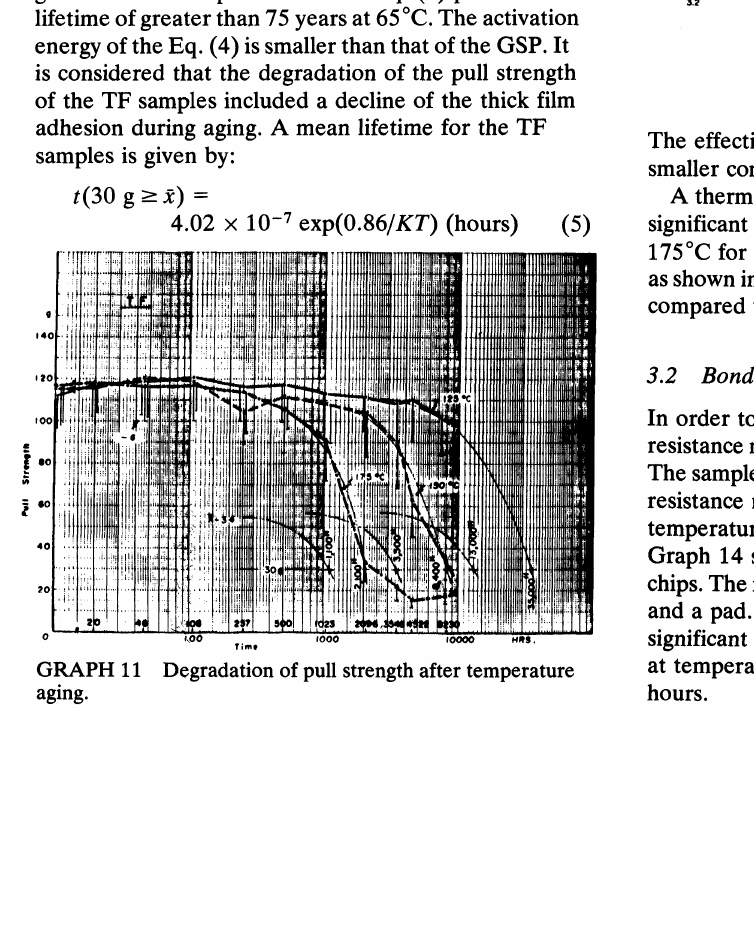
GRAPH 12 Arrhenius plots for